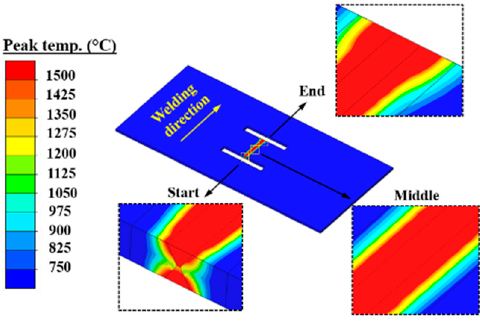
Figure 17. The contour of peak temperature distribution in case B-3.